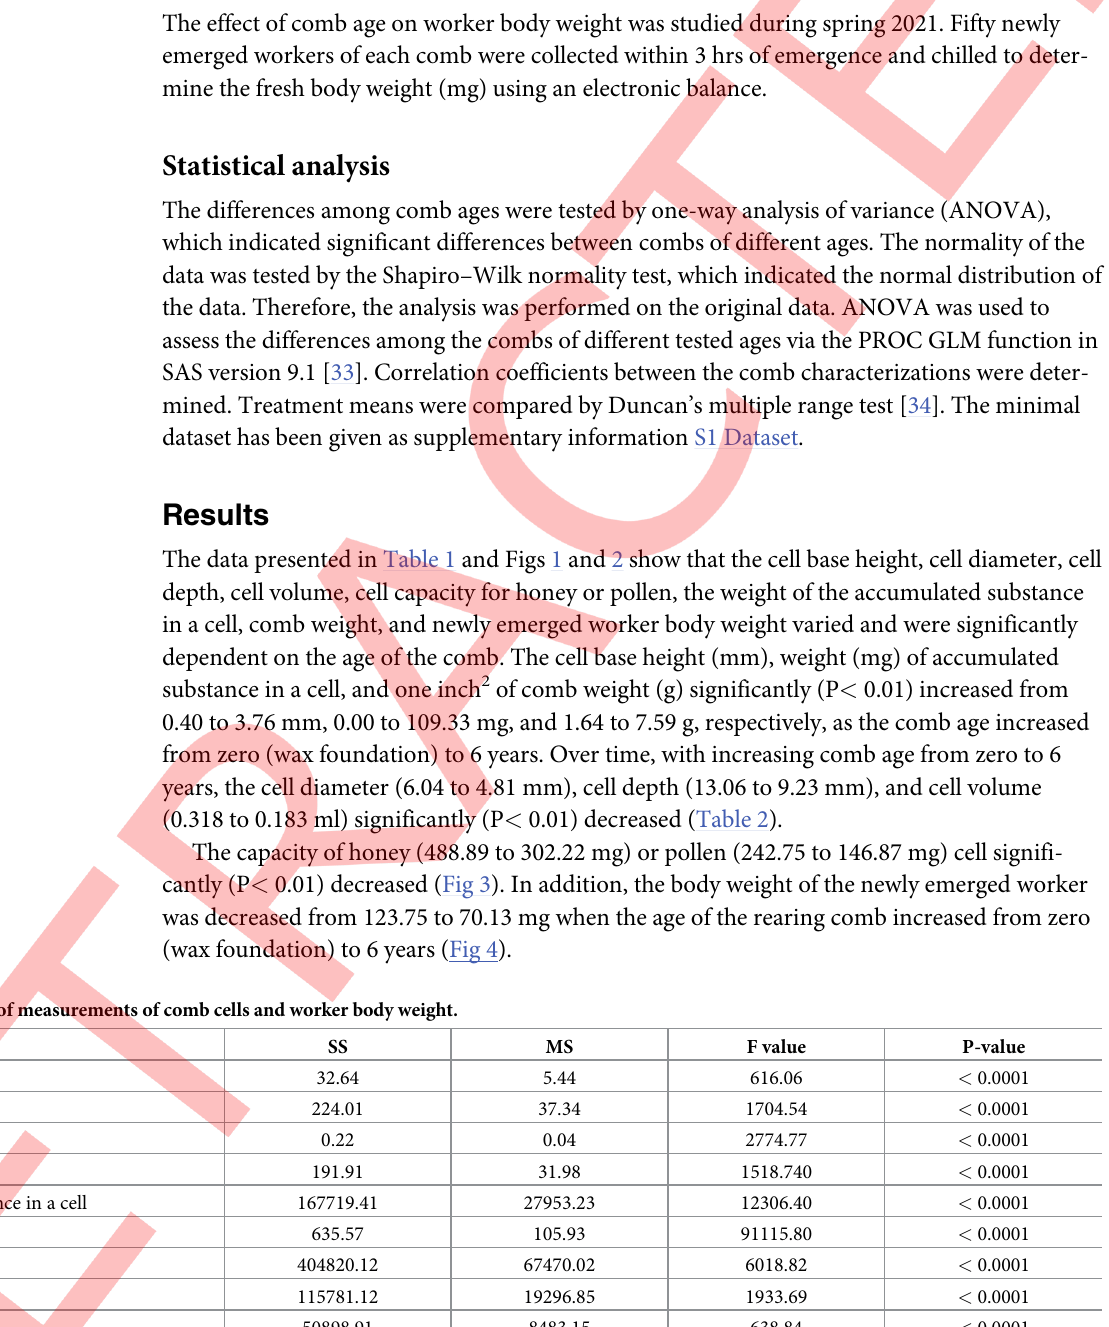
Newly emerged worker